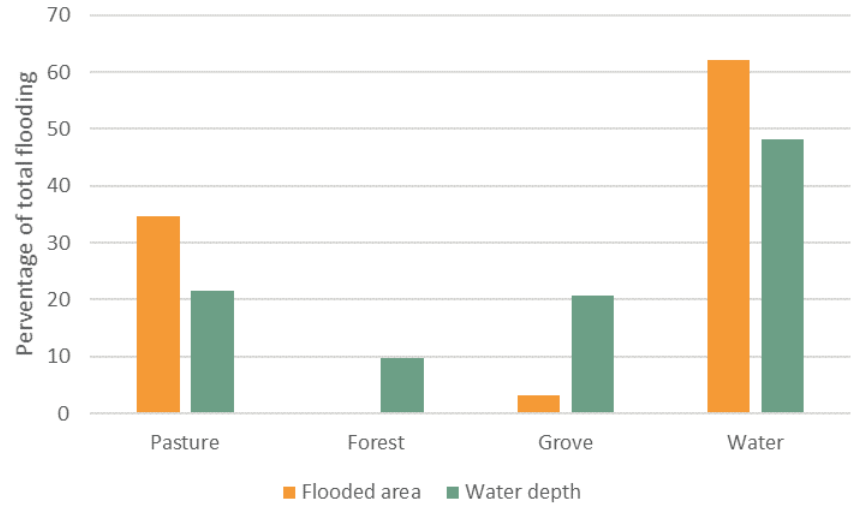
Figure 6. Water depth and flooded area by different land uses at the day with the highest water level during the simulated flood event in